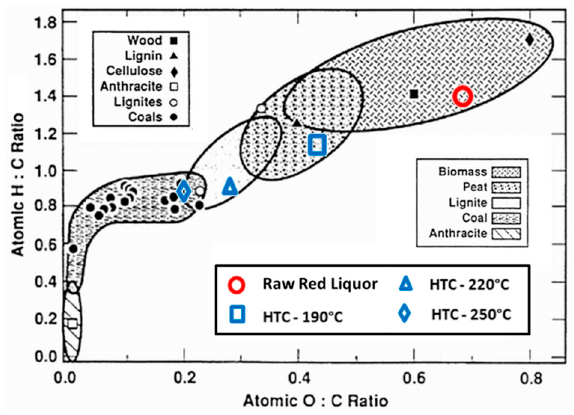
Figure 6. Atomic O/C ‐ H/C Ratios of Raw Red Liquor and HTC Sample 4 Hydrochars (adapted from Trif ‐ Tordai and Ionel via Wikimedia Commons [CC BY ‐ SA 3.0]).